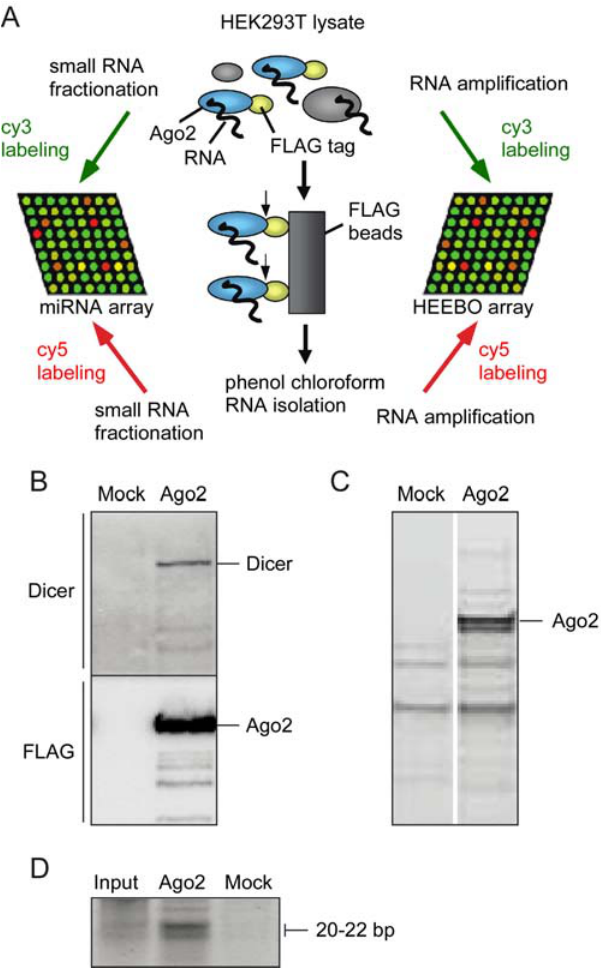
Figure 1. Ago2 association with Dicer and miRNAs. (A) Strategy for the systematic isolation and identification of RNA associated with Ago2. (B) Immunopurification of FLAG protein purified from mock transfected cells (left) and FLAG-Ago2 transfected cells (right). A Dicer antibody (top) and FLAG antibody (bottom) were immuno-reactive with bands corresponding to the predicted molecular weight of Dicer ( , 250 kD) and Ago2 ( , 90 kD). (C) SYRO ruby protein stain of FLAG immunopurifications from mock transfected cells (left) and FLAG-Ago2 transfected cells (right). (D) SYBR gold nucleic acid stain of small RNAs (20–40 bp) isolated from whole cell lysate (left), FLAG immunopurifica- tion from FLAG-Ago2 transfected cells (middle) and FLAG purification from mock transfected cells (right). Brackets outline expected migration of nucleic acids , 21 base pairs in length.